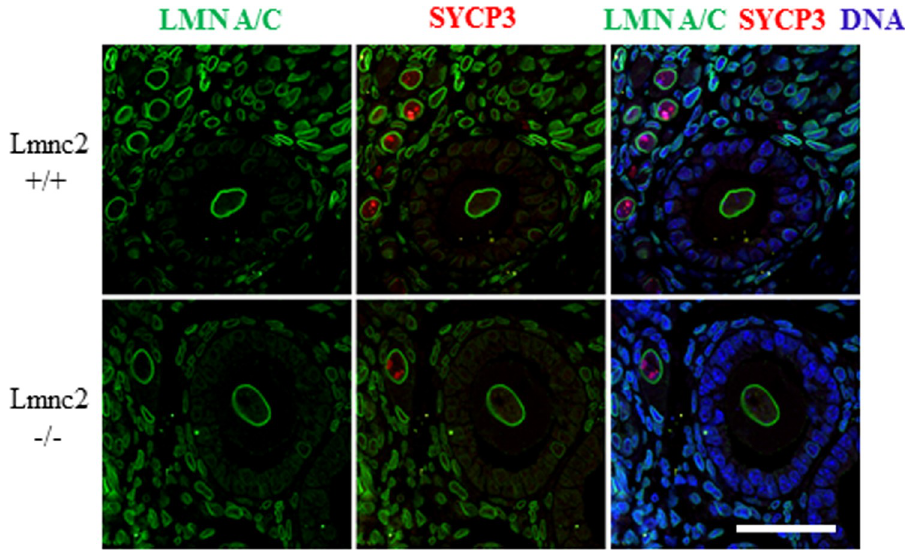
Fig 3. Oocytes from Lmnc2 -/- animals express A-type lamins and do not exhibit morphological abnormalities. Immunohistochemistry on 3 μ m paraffin sections of ovaries from 11-day old females of Lmnc2 +/+ (upper row) and Lmnc2 -/- (lower row) animals labeled with LMN A/C (green) and synaptonemal complex protein (SYCP3; red) antibodies. DNA is counterstained with Hoechst 33258 (blue); scale bar, 40 μ m.